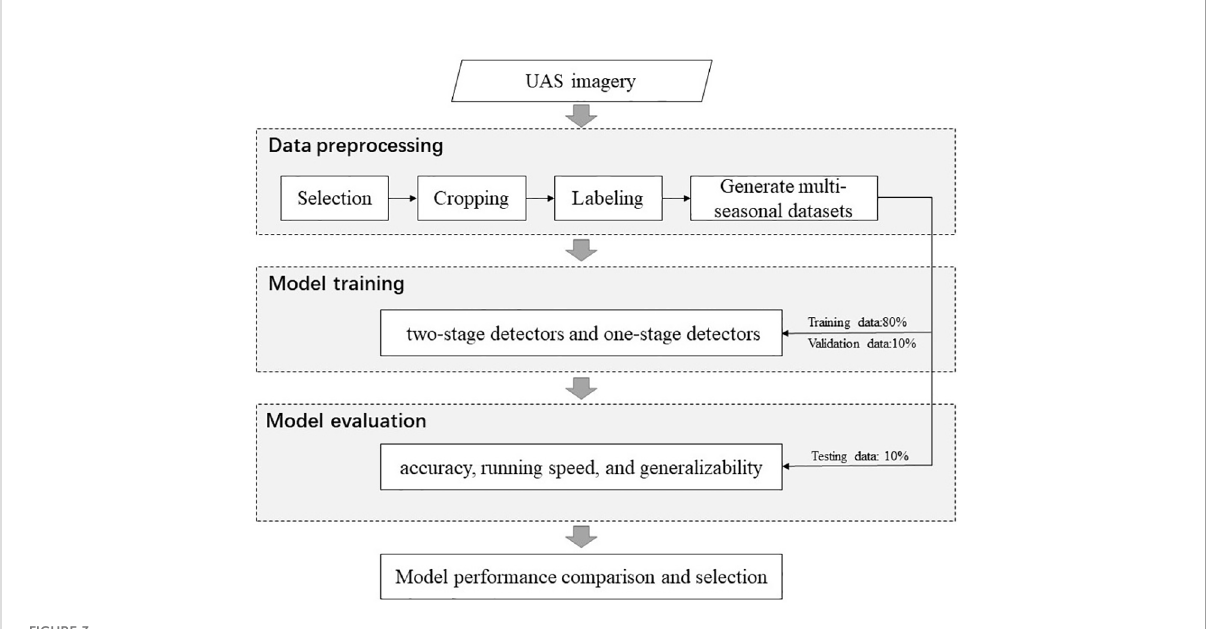
FIGURE 3 Work fl ow of this